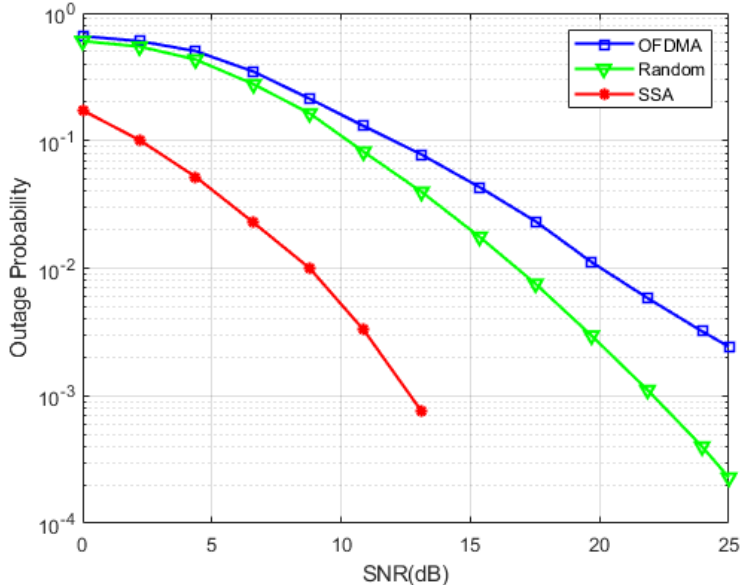
Figure 7. Outage probability versus SNR.